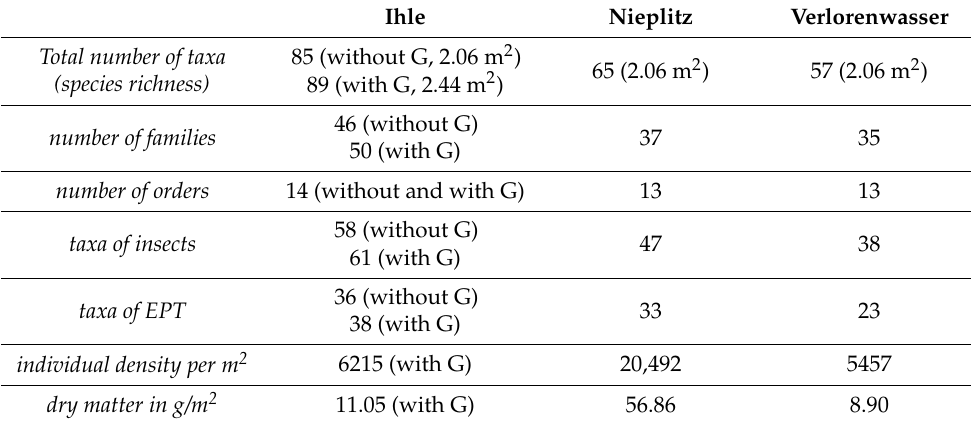
Table 2. MI-colonization of streams Ihle, Nieplitz and Verlorenwasser.